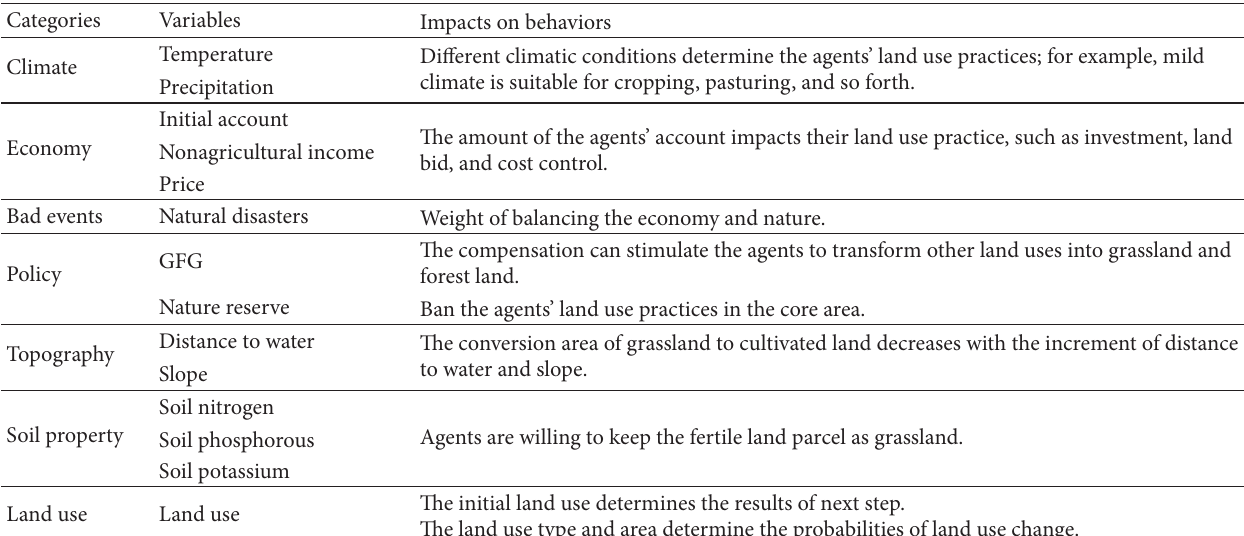
Table 1: The factors that impact the agents’